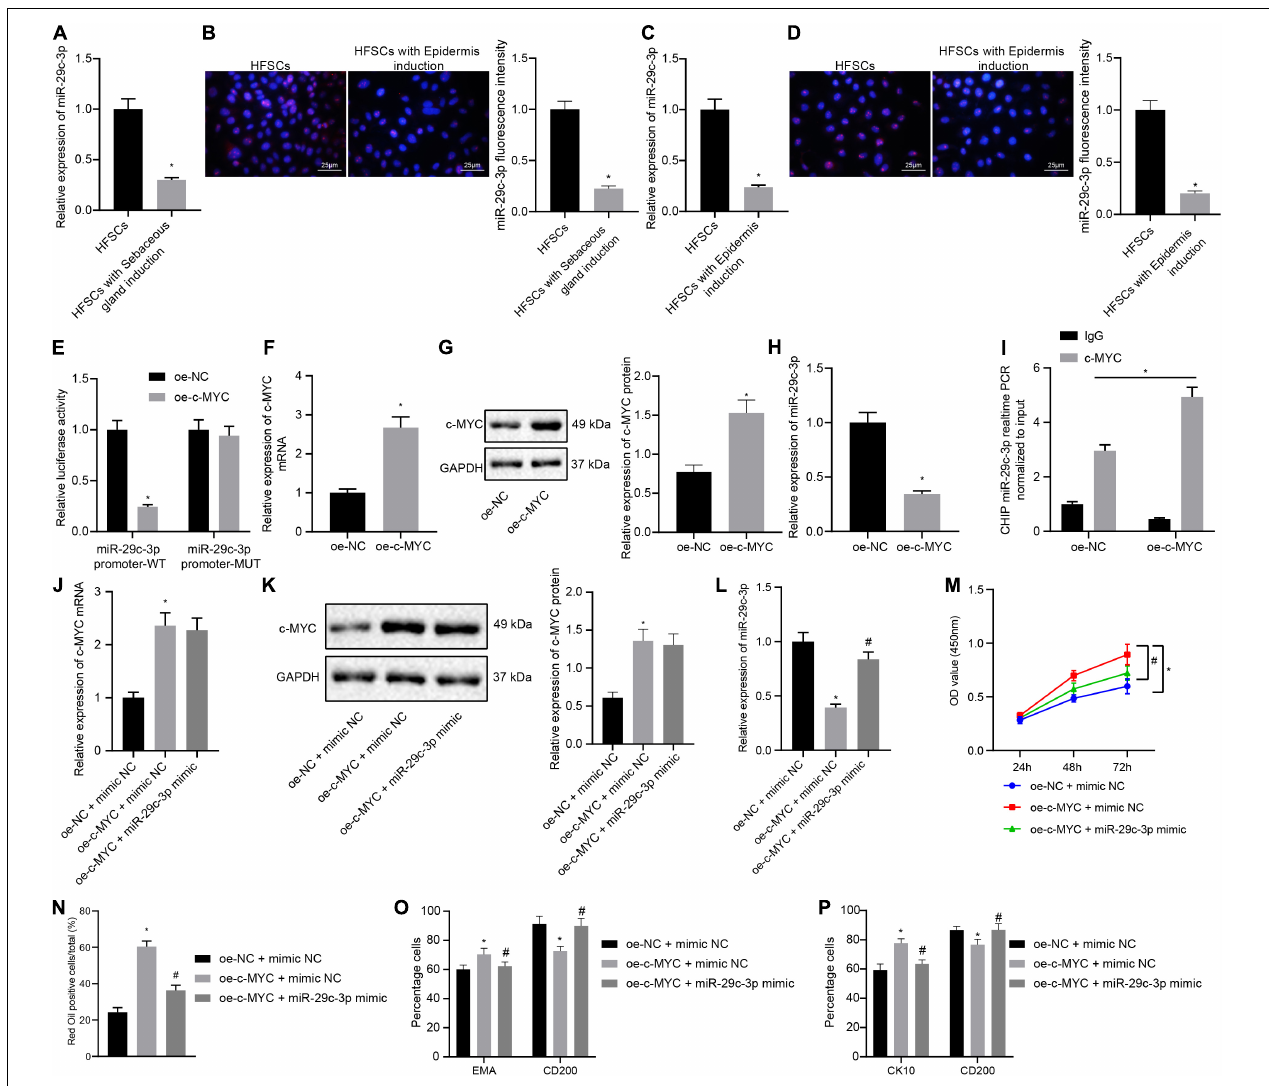
FIGURE 3 | c-MYC promotes the differentiation of HFSCs by down-regulating the expression of miR-29c-3p. (A) miR-29c-3p expression in HFSCs after differentiation of HFSCs into sebaceous gland cells as determined by RT-qPCR. * p < 0.05 compared with HFSCs or treatment of mimic NC. (B) miR-29c-3p fluorescence intensity in HFSCs after differentiation of HFSCs into sebaceous gland cells as determined by FISH assay. * p < 0.05 compared with HFSCs or treatment of mimic NC. (C) miR-29c-3p expression after differentiation of HFSCs into epidermal cells as determined by RT-qPCR. * p < 0.05 compared with HFSCs or treatment of mimic NC. (D) miR-29c-3p fluorescence intensity after differentiation of HFSCs into epidermal cells as determined by FISH assay. * p < 0.05 compared with HFSCs or treatment of mimic NC. (E) Detection of c-MYC binding to the miR-29c-3p promoter using the dual luciferase reporter gene assay. * p < 0.05 compared with treatment of oe-NC. (F) c-MYC mRNA expression in HFSCs treated with oe-c-MYC as determined by RT-qPCR. * p < 0.05 compared with treatment of oe-NC. (G) c-MYC protein level in HFSCs treated with oe-c-MYC as determined by Western blot analysis. * p < 0.05 compared with treatment of oe-NC. (H) miR-29c-3p expression levels in HFSCs treated with oe-c-MYC as determined by RT-qPCR. * p < 0.05 compared with treatment of oe-NC. (I) ChIP analysis of c-MYC binding to the miR-29c-3p promoter. (J) c-MYC mRNA expression in HFSCs determined by RT-qPCR. * p < 0.05 compared with treatment of oe-NC + mimic NC. # p < 0.05 compared with treatment of oe-c-MYC + mimic NC. (K) c-MYC protein level in HFSCs determined by Western blot analysis. * p < 0.05 compared with treatment of oe-NC + mimic NC. # p < 0.05 compared with treatment of oe-c-MYC + mimic NC. (L) miR-29c-3p expression levels in HFSCs were determined by RT-qPCR. * p < 0.05 compared with treatment of oe-NC + mimic NC. # p < 0.05 compared with treatment of oe-c-MYC + mimic NC. (M) CCK-8 assay used to detect the proliferation rate of HFSCs. * p < 0.05 compared with treatment of oe-NC + mimic NC. # p < 0.05 compared with treatment of oe-c-MYC + mimic NC. (N) Oil red O staining before and after the differentiation of HFSCs into sebaceous gland cells. * p < 0.05 compared with treatment of oe-NC + mimic NC. # p < 0.05 compared with treatment of oe-c-MYC + mimic NC. (O) Detection of EMA and CD200 expression before and after the differentiation of HFSCs into sebaceous gland cells. * p < 0.05 compared with treatment of oe-NC + mimic NC. # p < 0.05 compared with treatment of oe-c-MYC + mimic NC. (P) Detection of keratin CK10 and CD200 expression before and after the differentiation of HFSCs into epidermal cells. * p < 0.05 compared with treatment of oe-NC + mimic NC. # p < 0.05 compared with treatment of oe-c-MYC + mimic NC. The data are expressed as mean ± standard deviation, and comparisons between two groups were analyzed using unpaired t test. Comparisons among multiple groups were performed using one-way ANOVA and Tukey’s test. Comparisons among multiple groups at different time points were performed using two-way ANOVA and Bonferroni test. The experiment was repeated three times.